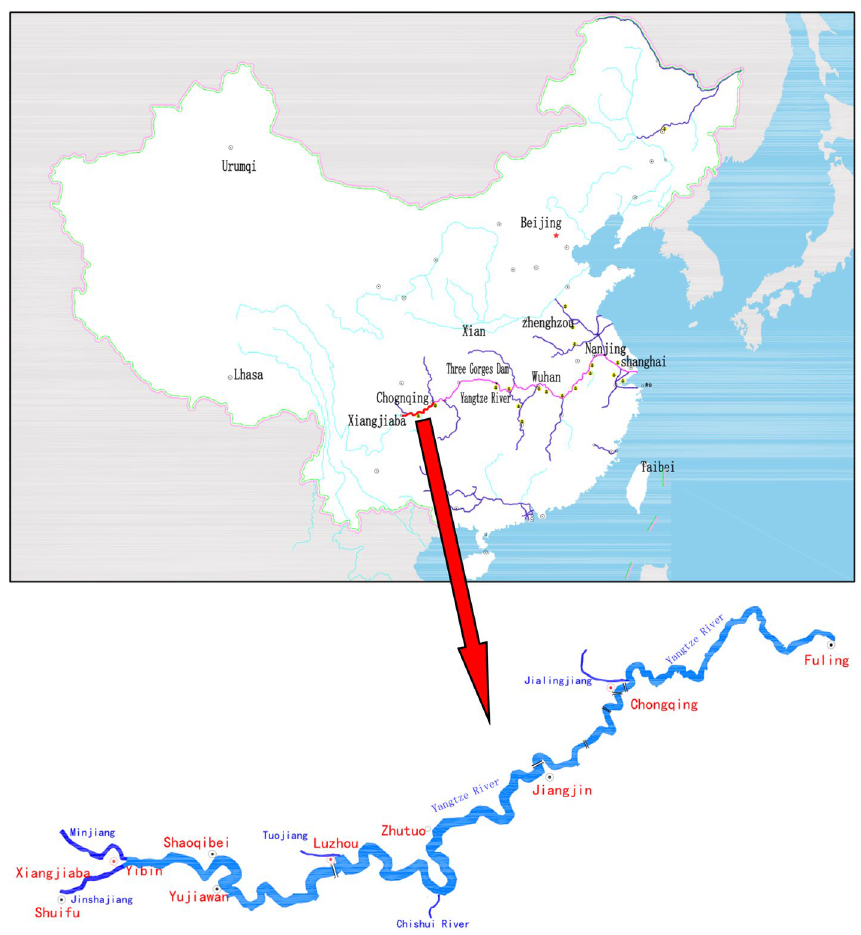
Fig. 1 Location of the Yangtze River (Xiangjiaba hydropower station to the Fuling reach) in